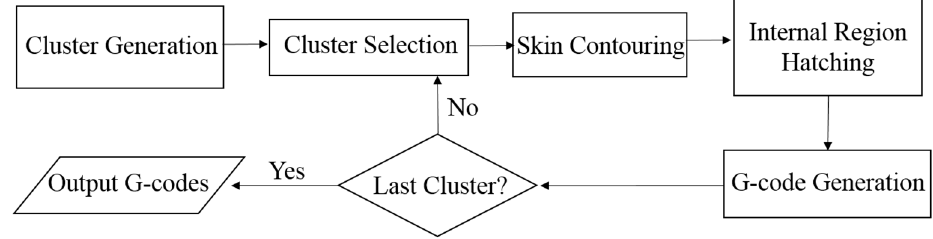
Figure 4. Flowchart of G-code generation for a slice.